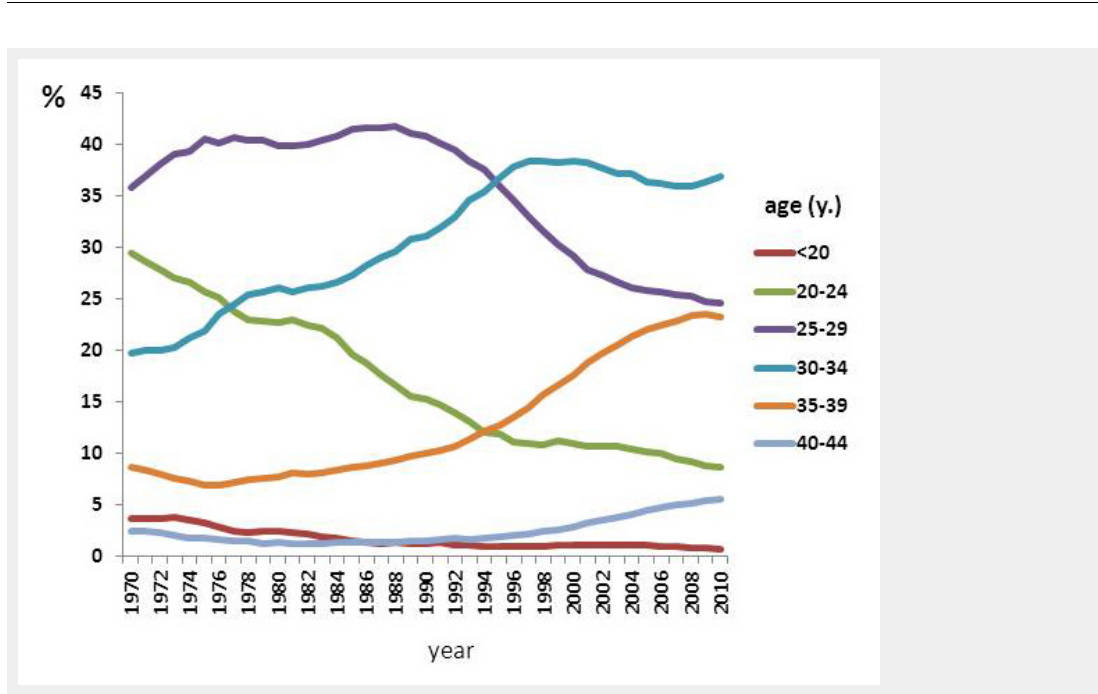
The age at delivery of women delivered in Switzerland since 1970 (Source: BfS ■■■). Whereas the number of women giving birth at the age of 30 y or less is on the decline since 1990, the number of older women giving birth is on the rise, in particular those above the age of 35 years.